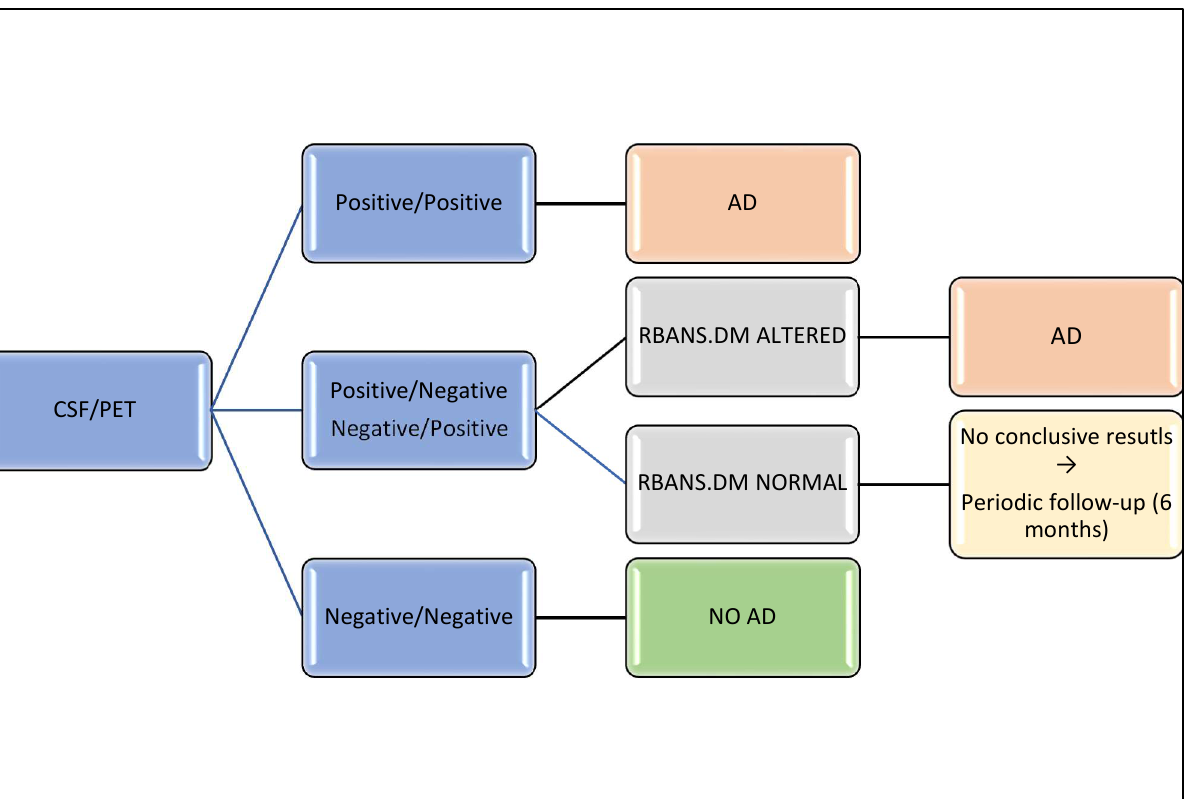
Figure 5. Decision tree for AD diagnosis based on CSF biomarkers, amyloid PET, and RBANS.DM score.